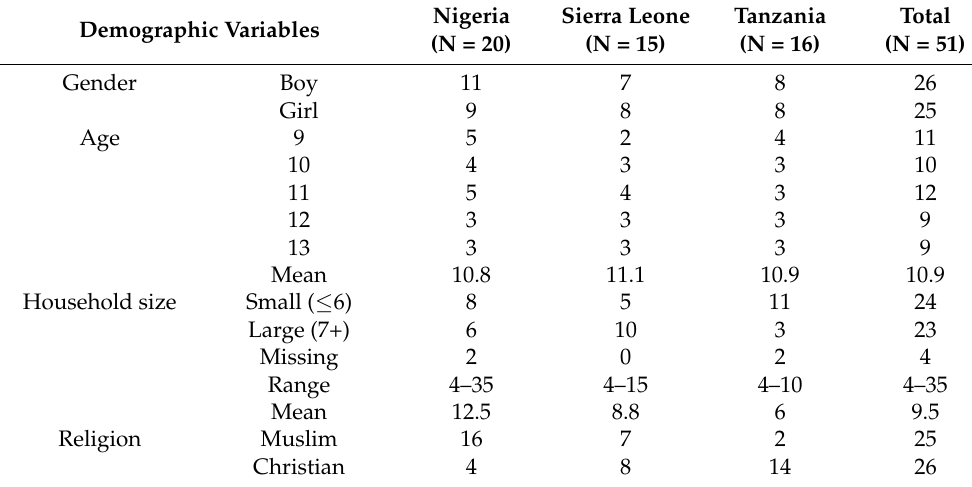
Table 1. Main demographic variables used to stratify